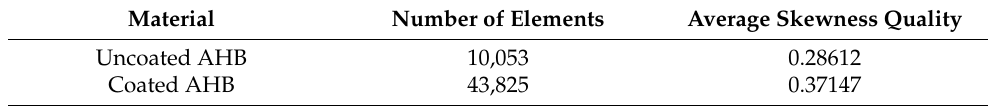
Figure 6. Mesh convergence study based on the heat flux density. Table 2. The number of elements and average skewness quality.